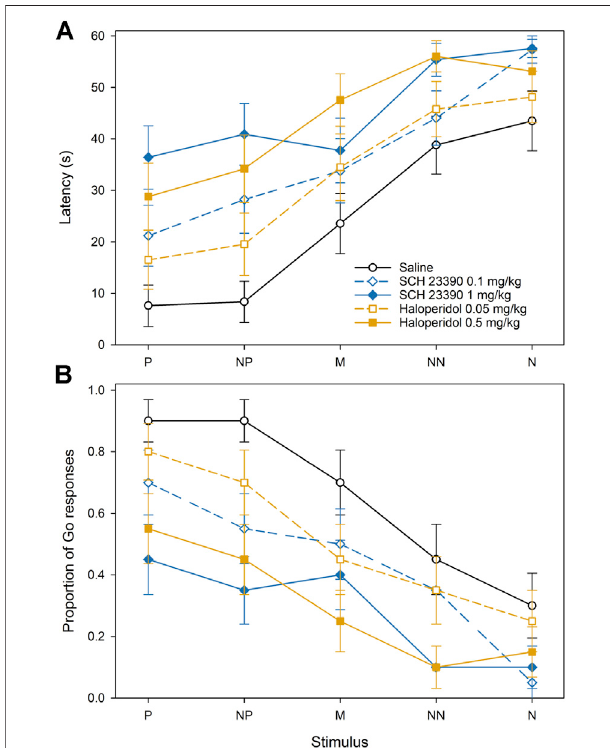
FIGURE 3 | The effect of dopamine D1 and D2 receptor antagonists on the approach latencies (A) and a mean proportion of Go responses (B) of Japanese quail hens in the spatial judgment task. Mean ± SEM of the approach latencies to the positive (P), near-positive (NP), middle (M), near-negative (NN), and negative (N) cues.